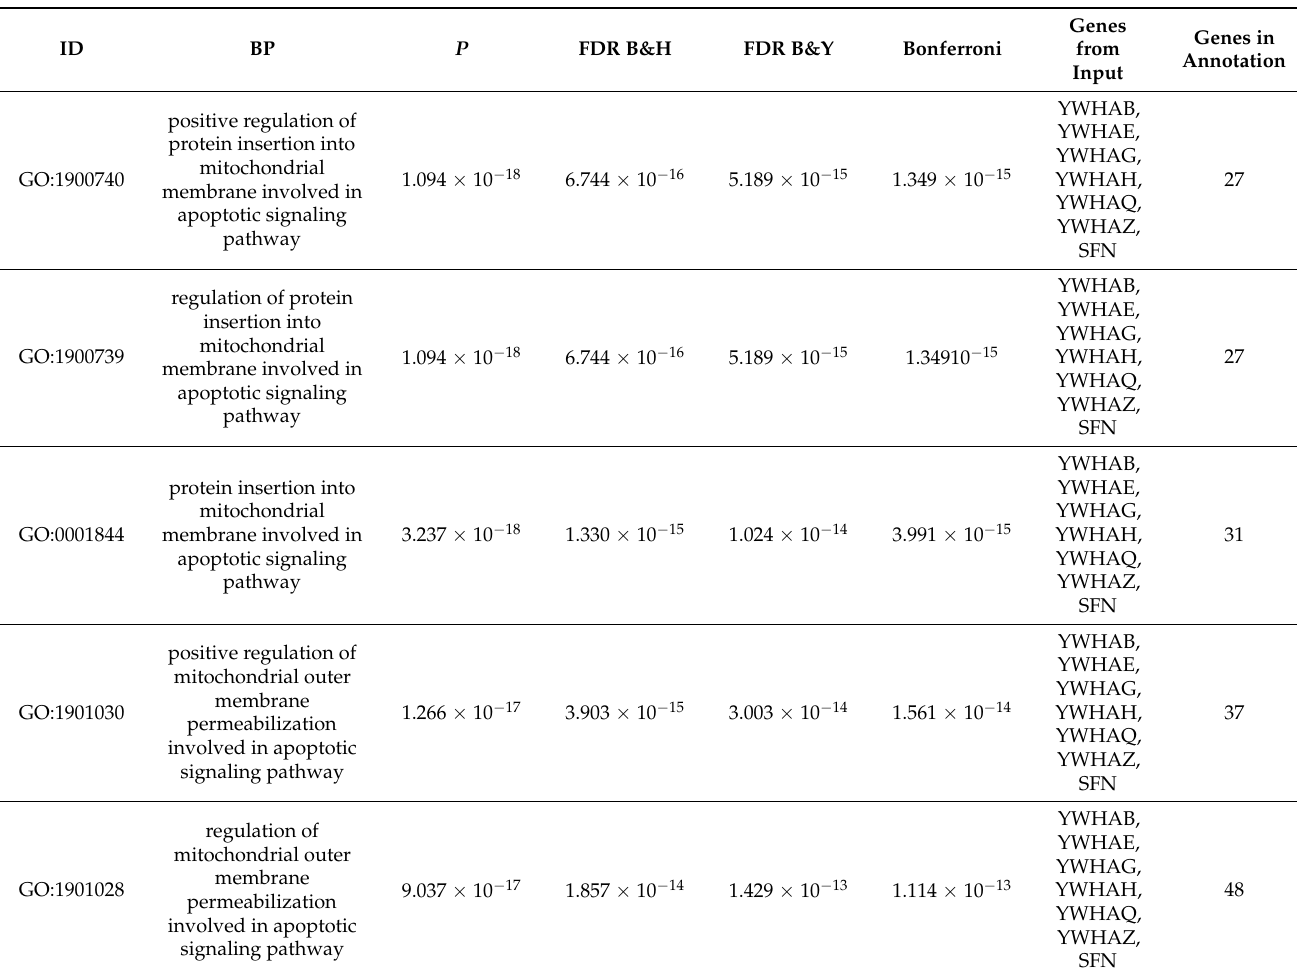
Table 2. The top 5 annotations of the ToppFun FEA for BP GOs.